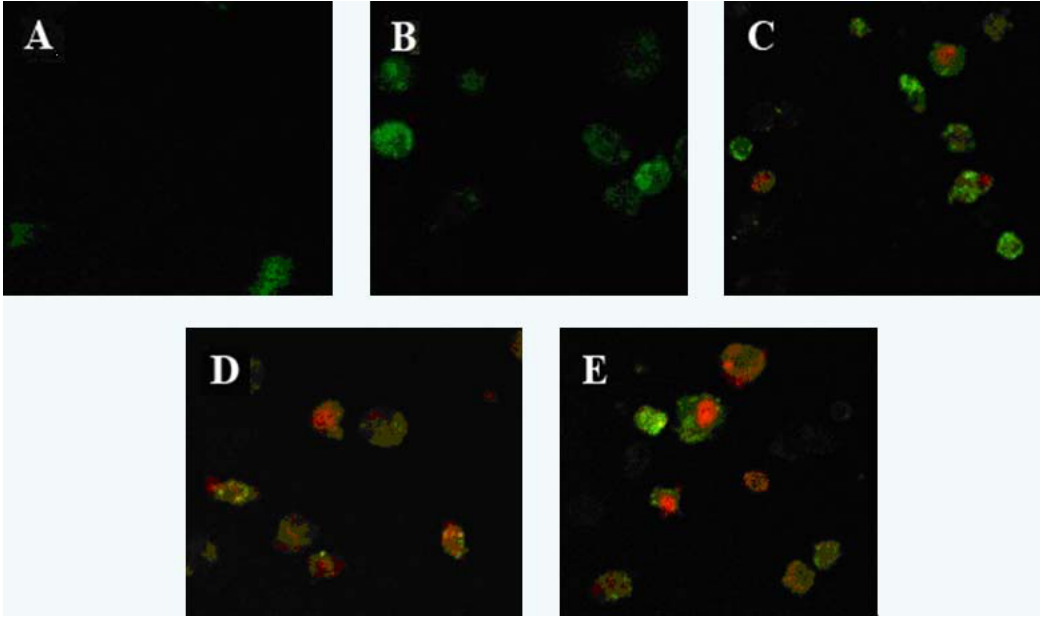
Figure 2. Effect of laminarin on LOVO cells morphology. ( A ) Cells were treated as control group; ( B ) Cells were treated with 400 µg · mL − 1 laminarin; ( C ) Cells were treated with 800 µg · mL − 1 laminarin; ( D ) Cells were treated with 1,600 µg · mL − 1 laminarin; ( E ) Cells were treated with 5 µg · mL − 1 HCPT.